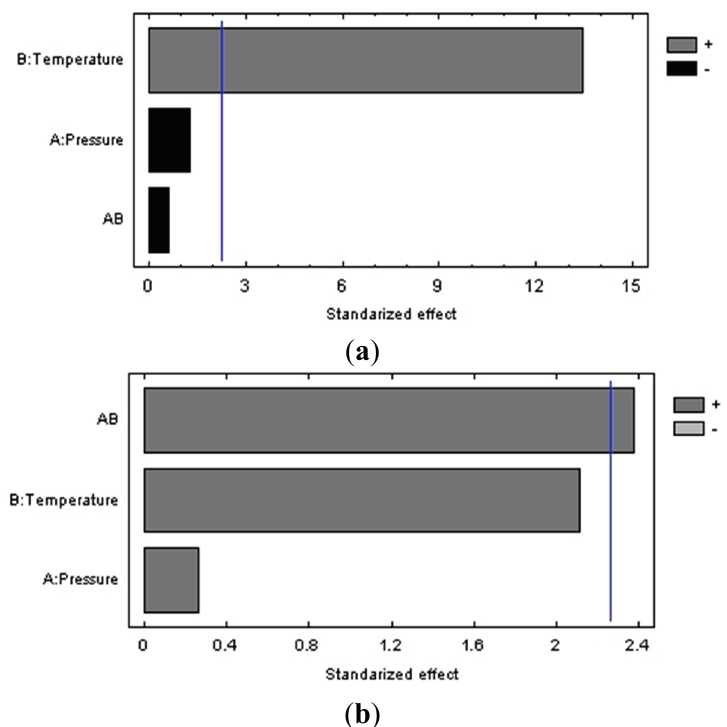
Figure 5. Pareto diagram ( a ) for the global extraction yield ( b ) for the antioxidant activity, obtained by PLE with ethanol/water (50:50) from Petit Verdot grape